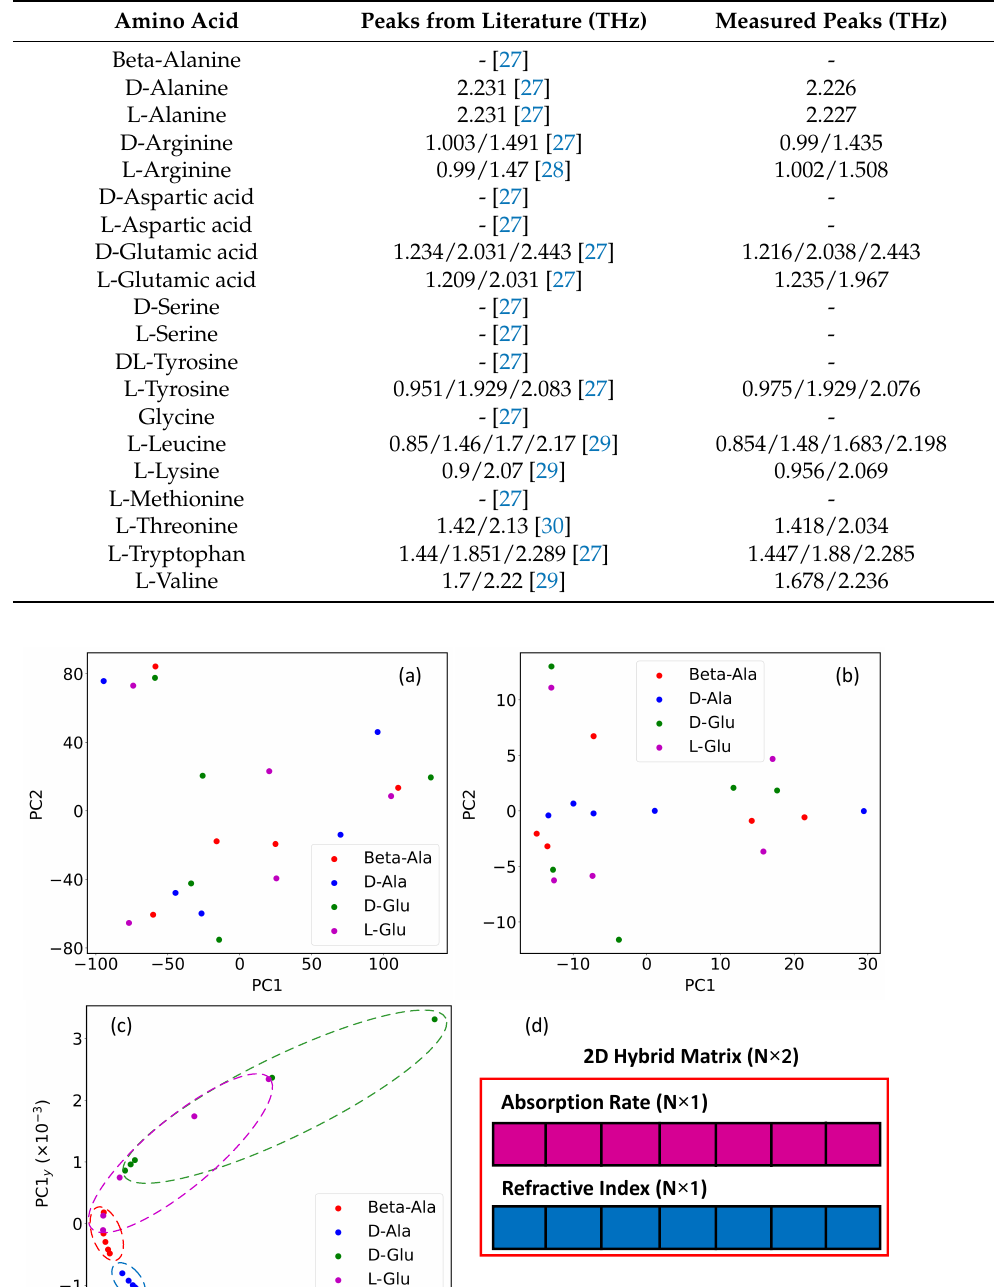
circles in Figure 4c. The hybrid spectrum combined with absorption rate and refractive index is explained by Figure 4d and will be used to classify the amino acids in later discussions. Table 1. The absorption peaks of the 20 amino acids.- represents no specific absorption peak is available in the frequency range.